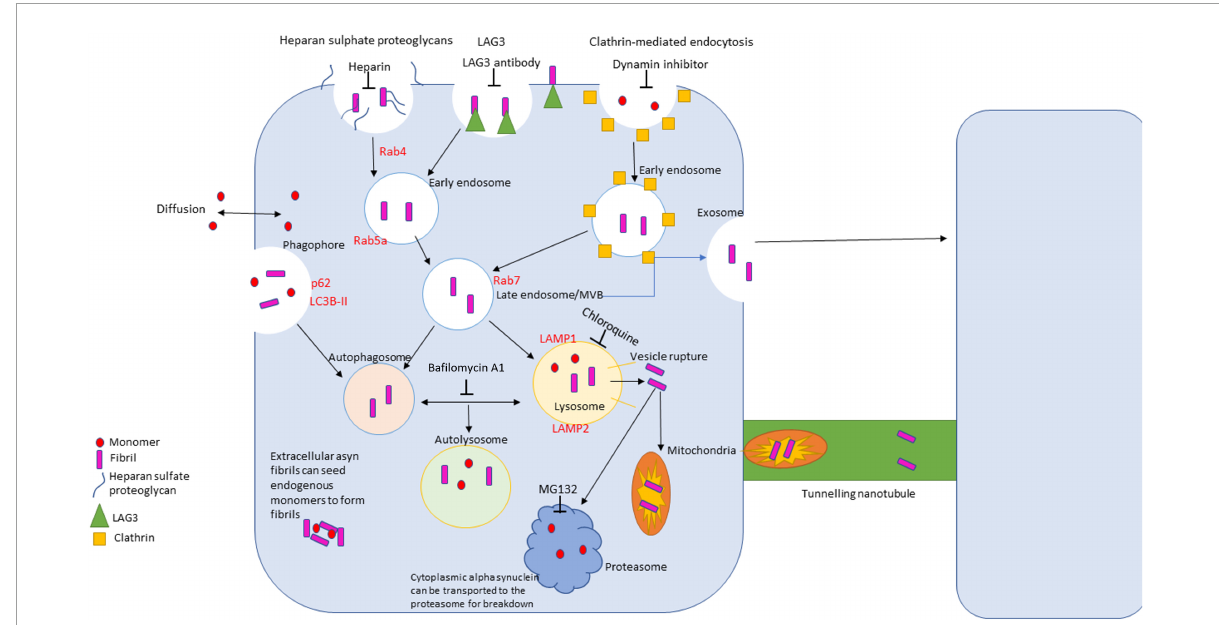
FIGURE3 Diagram of uptake, trafficking and clearance mechanisms of α -synuclein in the cell. There are four primary routes of uptake of α -synuclein into the cell: clathrin-mediated, LAG3 receptor-mediated, heparan sulfate proteoglycans-mediated, and passive diffusion. Different conformations of α -synuclein can be internalized via different routes. The autophagolysosomal pathway and the ubiquitin proteasome pathway are the primary clearance mechanisms that degrade α -synuclein. The autophagolysosome pathway can degrade larger species of α -synuclein, where the proteosome breaks down monomers and small, soluble